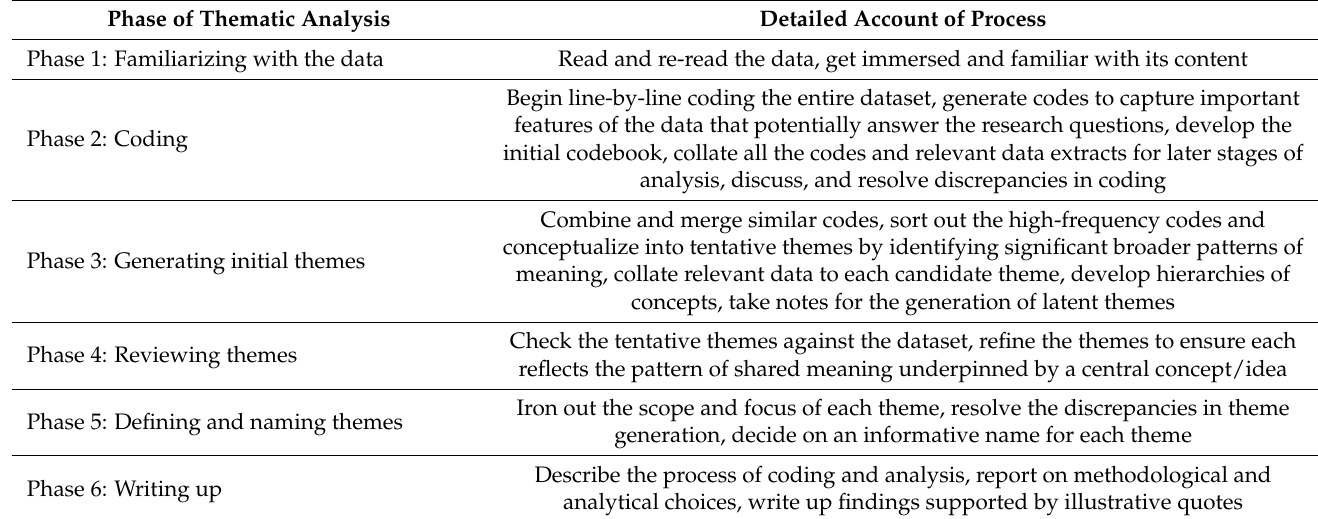
Table 3. Phases of thematic